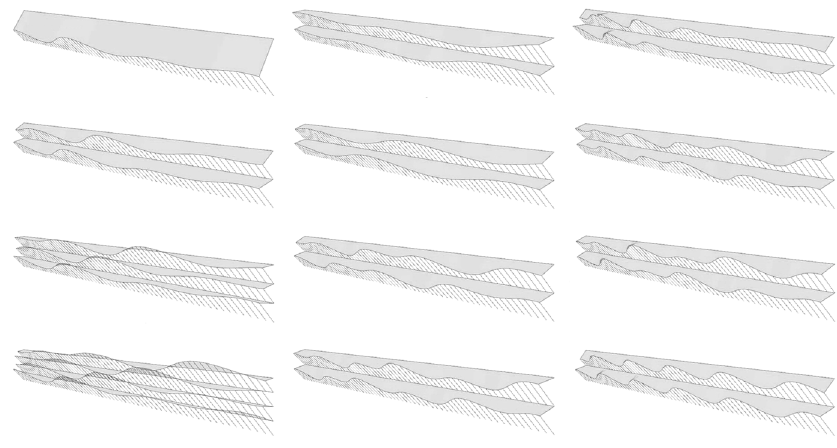
Figure 7. The possibility of façade design (Participant C).